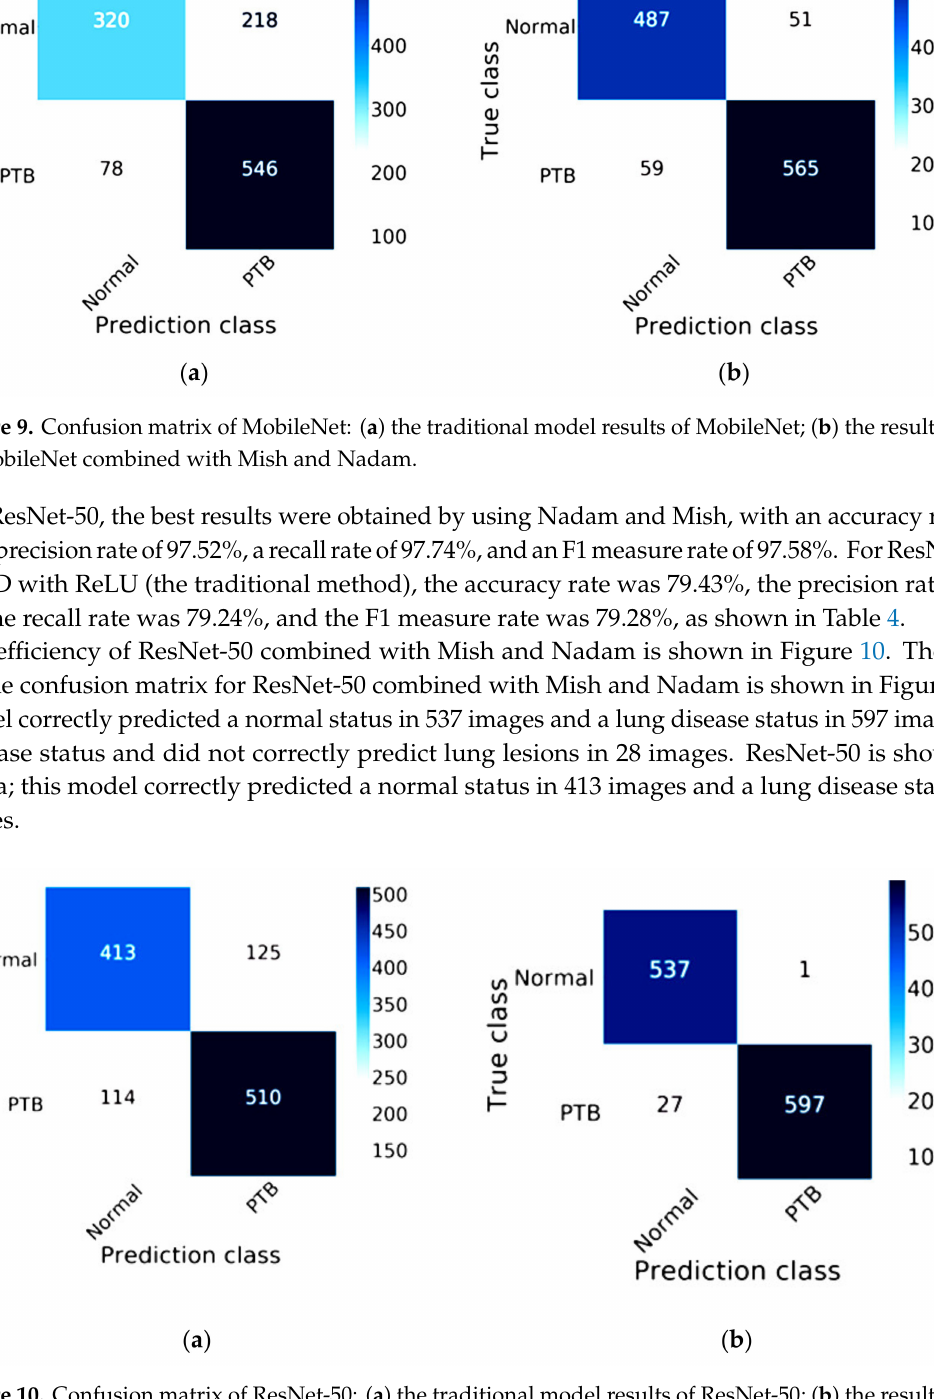
Figure 10. Confusion matrix of ResNet-50: ( a ) the traditional model results of ResNet-50; ( b ) the results of ResNet-50 combined with Mish and